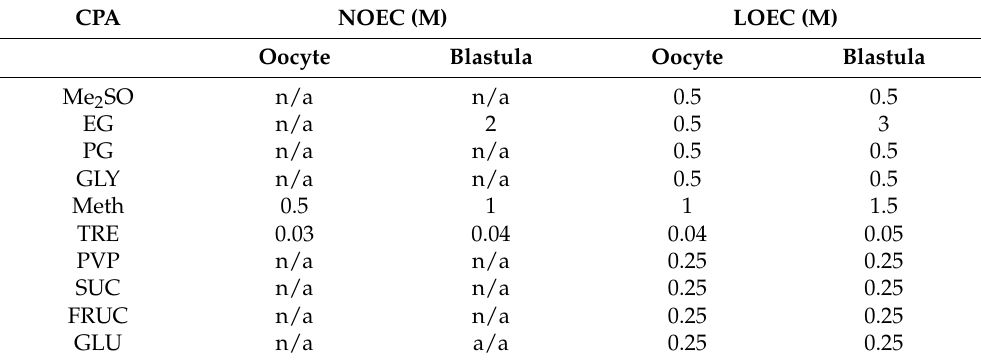
Table 2. Results of cryoprotecting agents (CPA) toxicity as No Observed Effective Concentration (NOEC) and Lowest Observed Effect Concentration (LOEC) for 2 cell types of Sphaerechinus granularis , following the methodology by